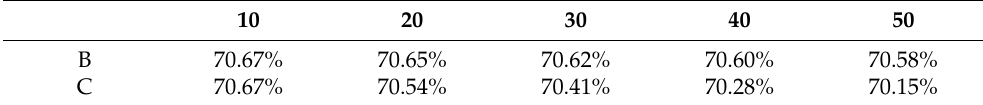
Table 2. The radiation efficiency of the antenna under two conditions B and